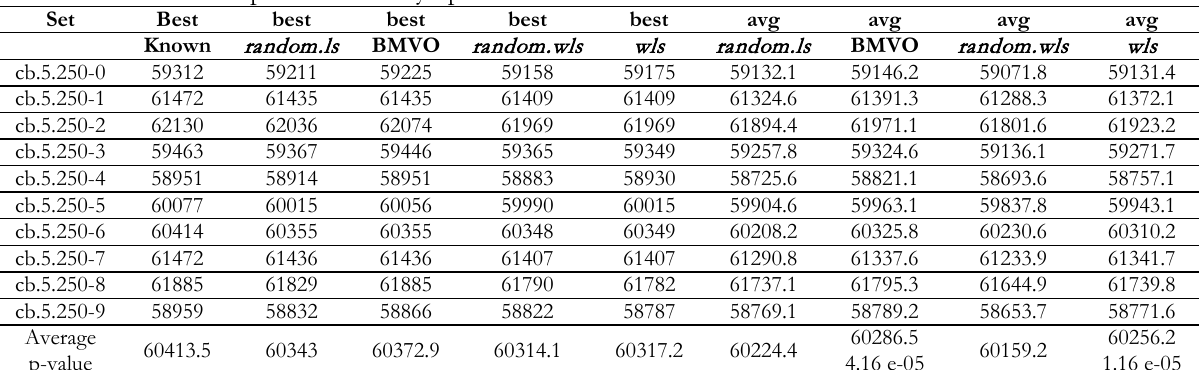
Table 2. Evaluation of percentile binary operator Set